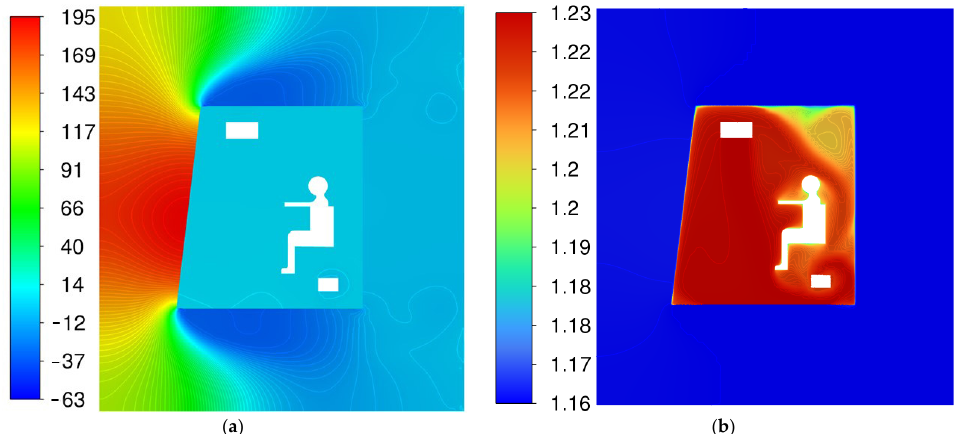
Figure 4. ( a ) Relative pressure, Pa; ( b ) air density, kg/m 3 .